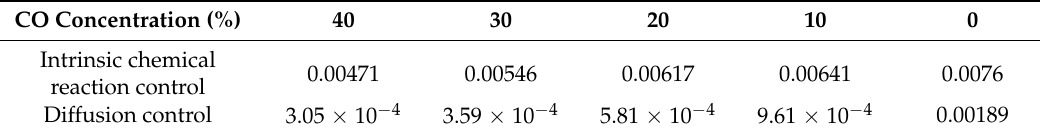
Figure 8. Plots of ( a ) 1 − ( 1 − X ) 1 3 vs time and ( b ) 1 − 2 concentrations of CO at 1273 K. Table 7. Values of gasification rate constant with various concentrations of CO at 1273 K.